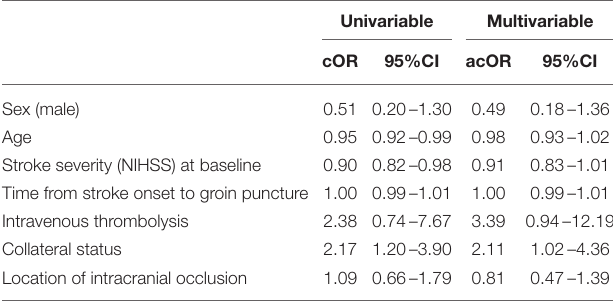
TABLE 3 | Univariable and multivariable analysis of functional outcome in EVT-treated patients with CAD.